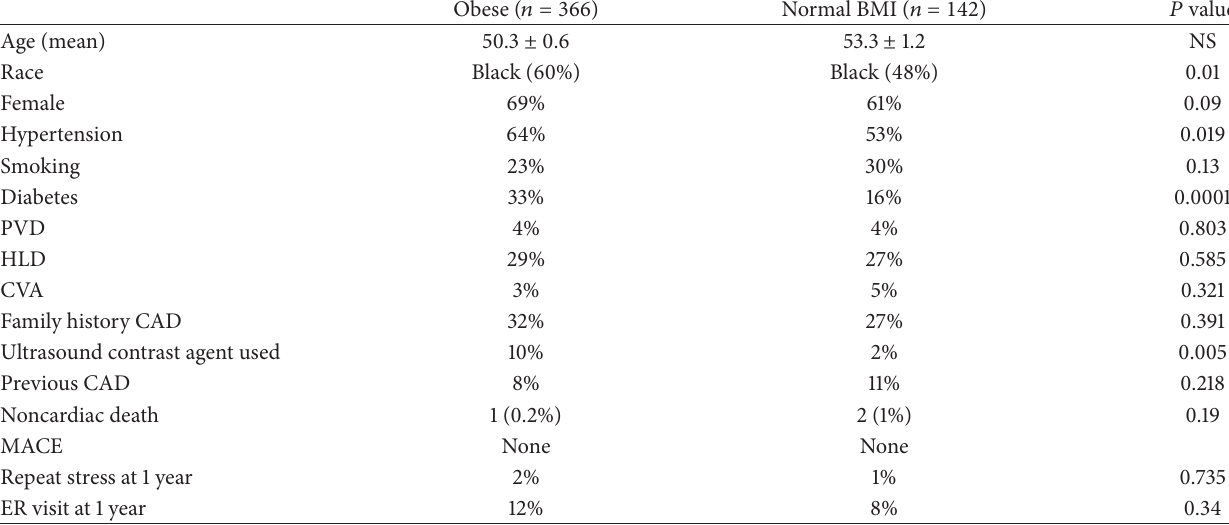
Table 1: Patient characteristics in the study